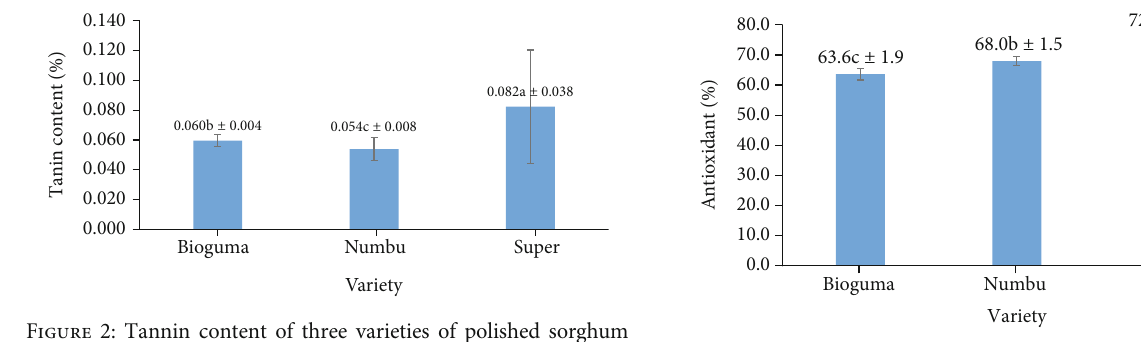
Figure 4: Antioxidant capacity (% RSA) of three varieties of polished